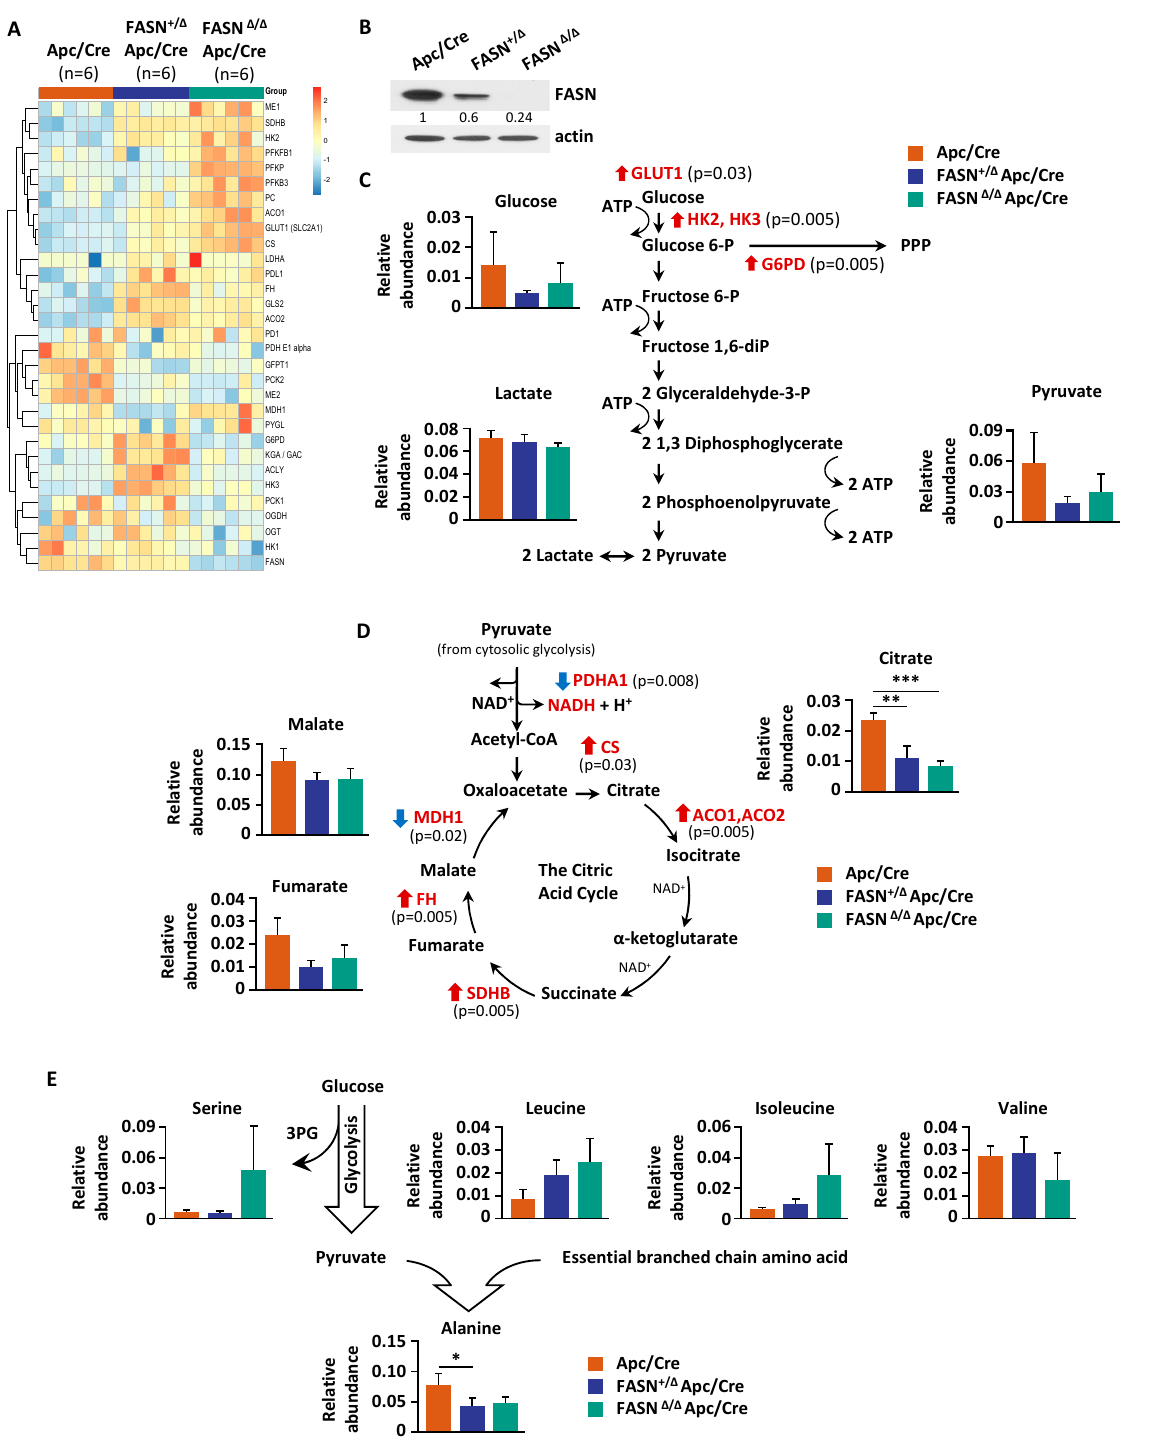
Figure 5. FASN knockdown alters the levels of metabolites and metabolic enzymes involved in glycolysis, TCA cycle, and amino acid metabolism. ( A ) Heat map demonstrating expression of metabolic enzymes as determined by Reverse Phase Protein Array (RPPA) analysis. ( B ) The level of FASN expression by western blot of mouse adenomas used for RPPA analysis. ( C ) FASN-mediated changes in metabolites and metabolizing enzymes within glycolysis. ( D ) FASN-mediated changes in metabolites and metabolizing enzymes within the TCA cycle. ( E ) Hetero- and homozygous knockdown of FASN alters the levels of branched-chain amino acids and decreases synthesis of alanine. (* p < 0.05, ** p < 0.01, *** p < 0.001).